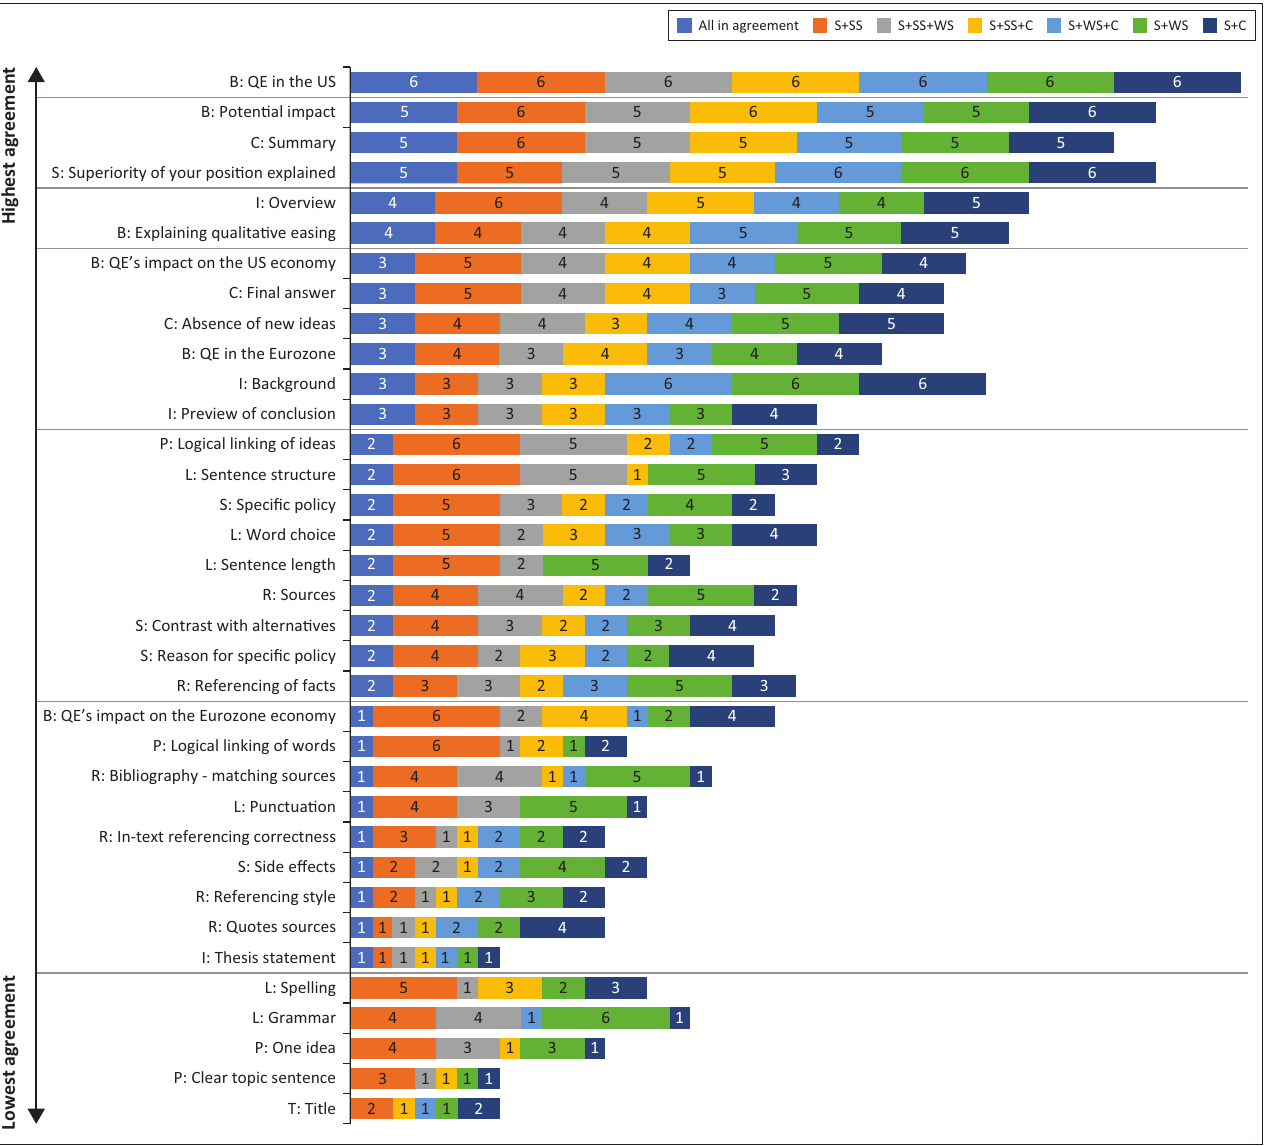
FIGURE 3: The count of cases where there is an agreement on each topic in all six student documents among the